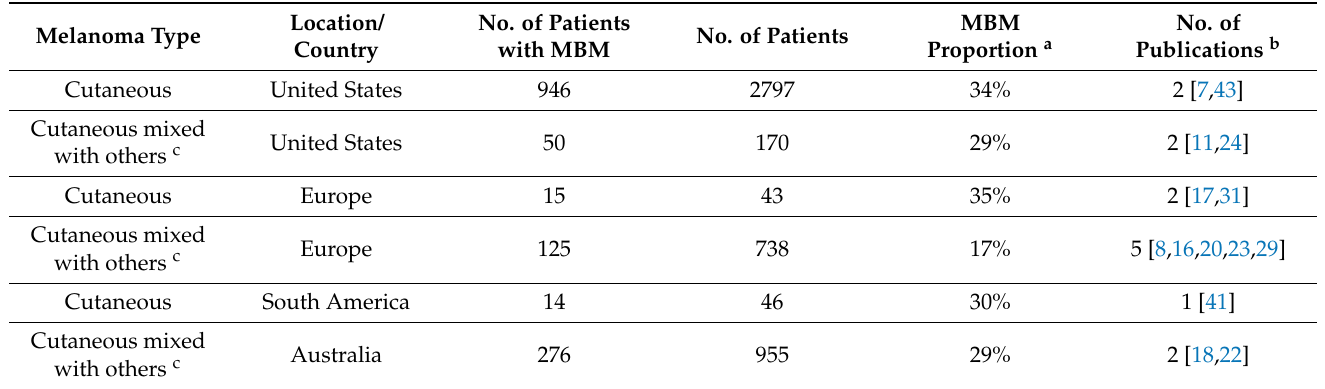
Table 2. Proportion of MBM at diagnosis by cutaneous melanoma or cutaneous mixed with others, and geographic